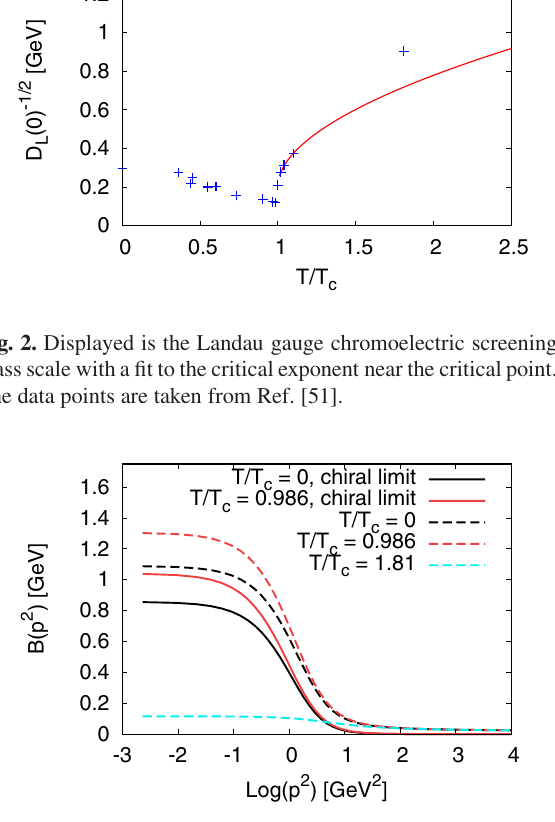
Fig. 3. The Landau gauge scalar quark function B ( p 2 ) (see Eq. (5)) for di ff erent temperatures in the chiral limit (solid lines) and for a typical light-quark current quark mass (dashed lines).